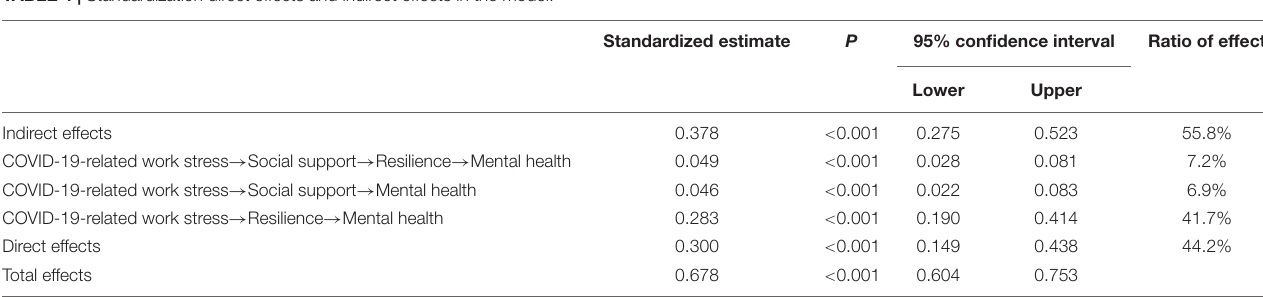
TABLE 4 | Standardization direct effects and indirect effects in the